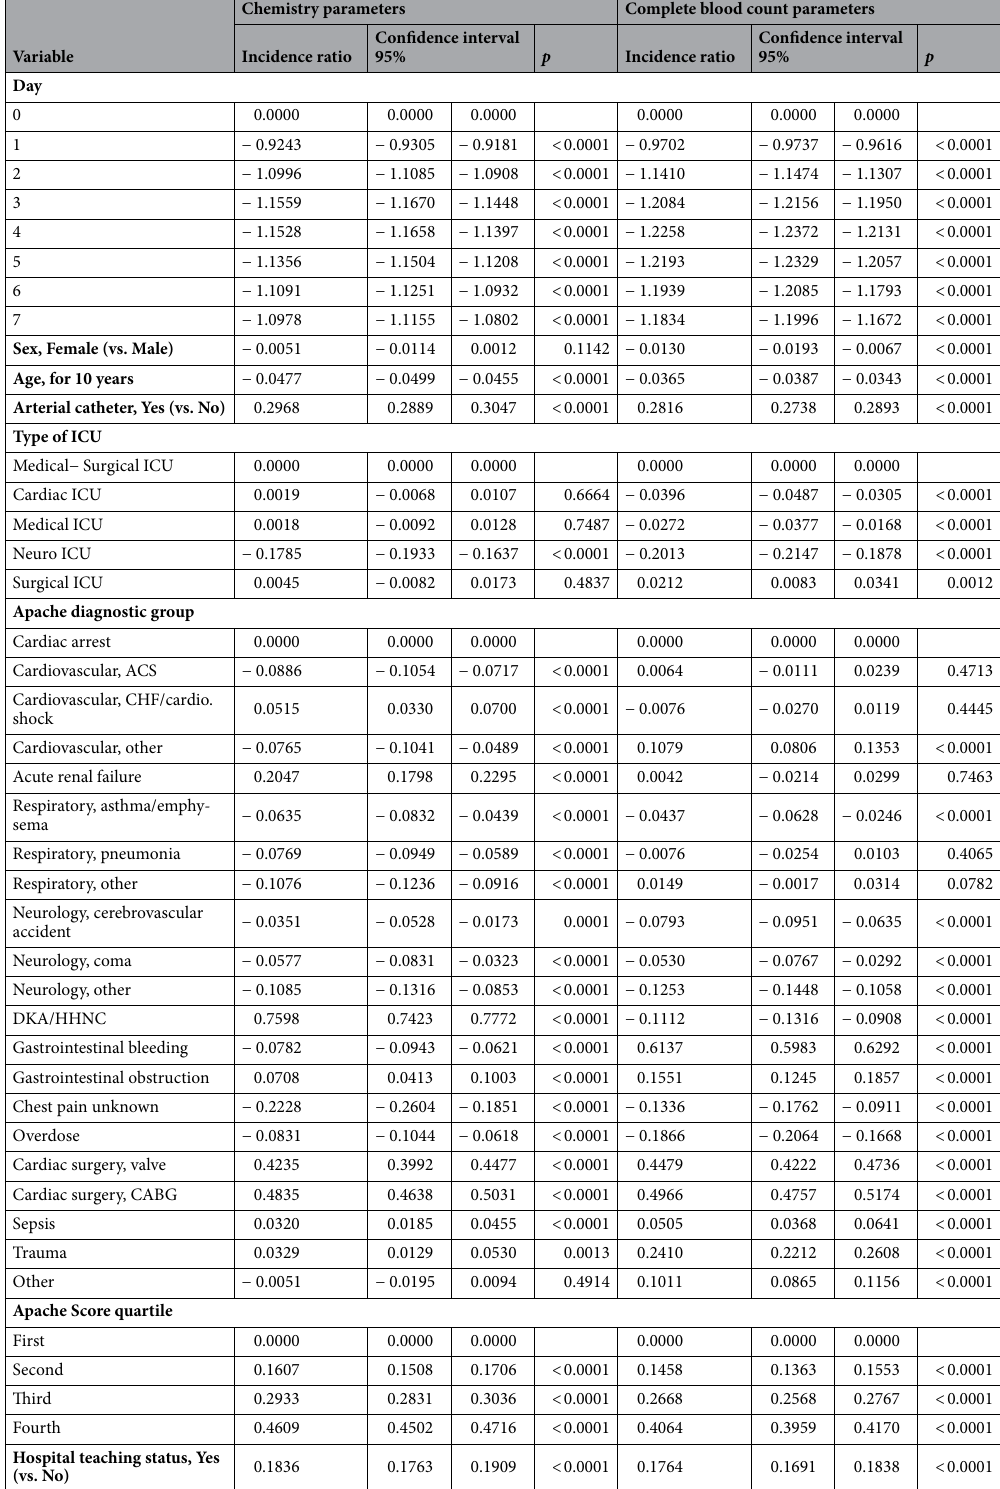
Table 4. Multivariate regression using GEE Poisson models. ACS, Acute coronary syndrome; APACHE, Acute Physiology and Chronic Health Evaluation; CABG, coronary artery bypass grafting CHF/cardio; shock, cardiac heart failure/cardiogenic shock; DKA/HHNC, Diabetic ketoacidosis/hyperglycemic hyperosmolar nonketotic coma; ICU, intensive care